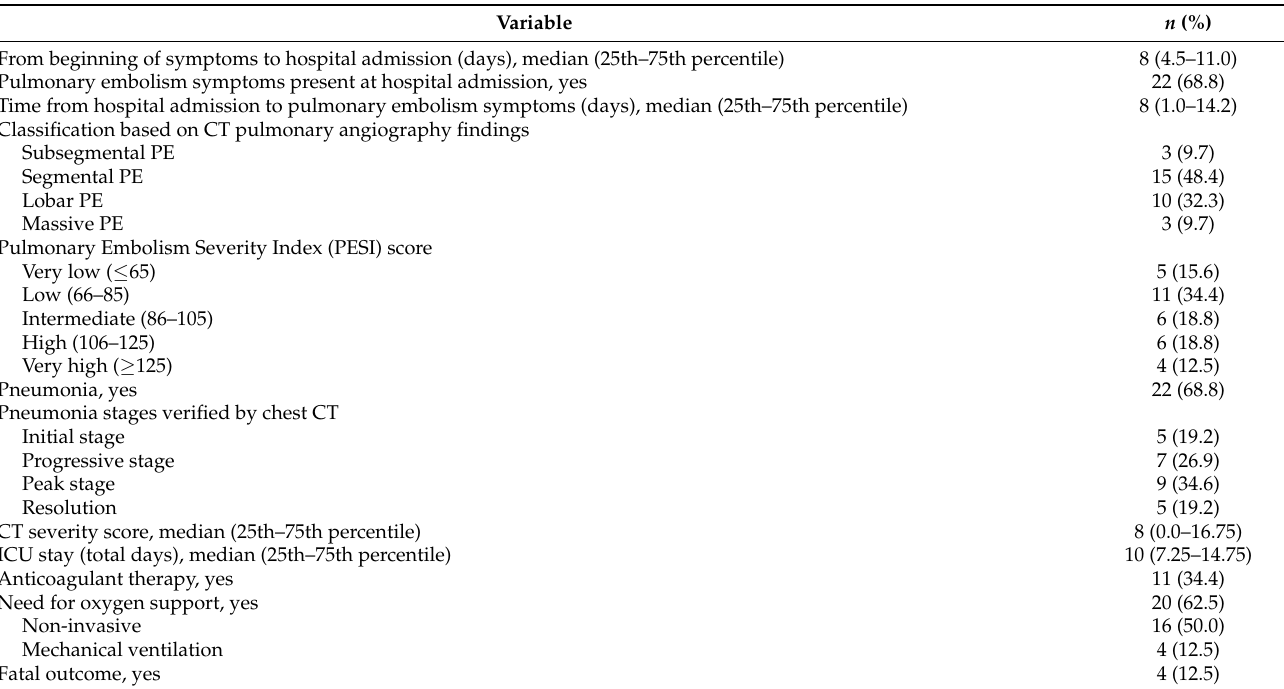
Table 2. Clinical parameters of the study